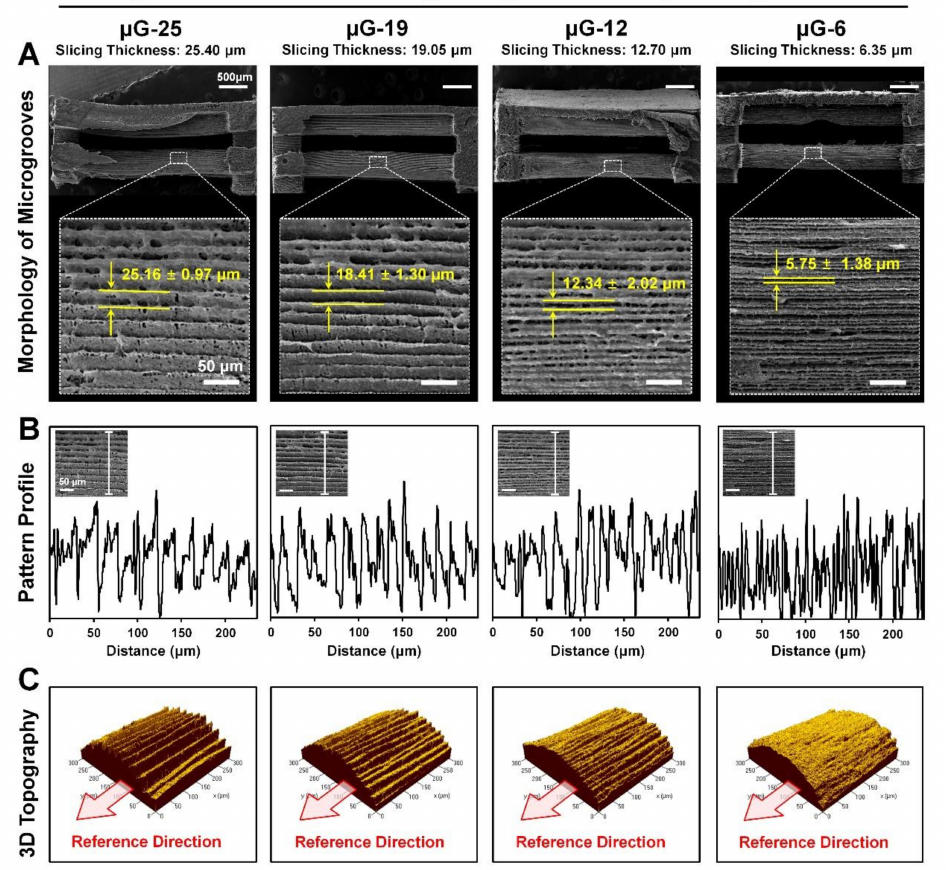
Figure 2. Qualitative and quantitative assessments to identify di ff erent of microgroove pattern intervals. ( A ) Scanning electron microscope (SEM) showed surface morphologies with the statistically calculated microgroove intervals in four di ff erent groups ( µ G-25, µ G-19, µ G-12, and µ G-6) by di ff erent slice thickness. ( B ) Based on the SEM images, microgroove patterns were quantitatively analyzed and profiled by crossing the pattern surfaces on PDL-guiding architectures. ( C ) Using the confocal microscope, surface topographies were characterized, as was surface